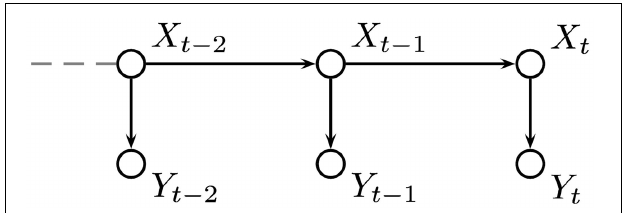
FIGURE 8 | Graphical representation of our hidden Markov model (HMM). The environmental state at trial t is denoted by X t and its value depends only on its value at the previous trial. The outcome is represented by Y t and depends only on X t .